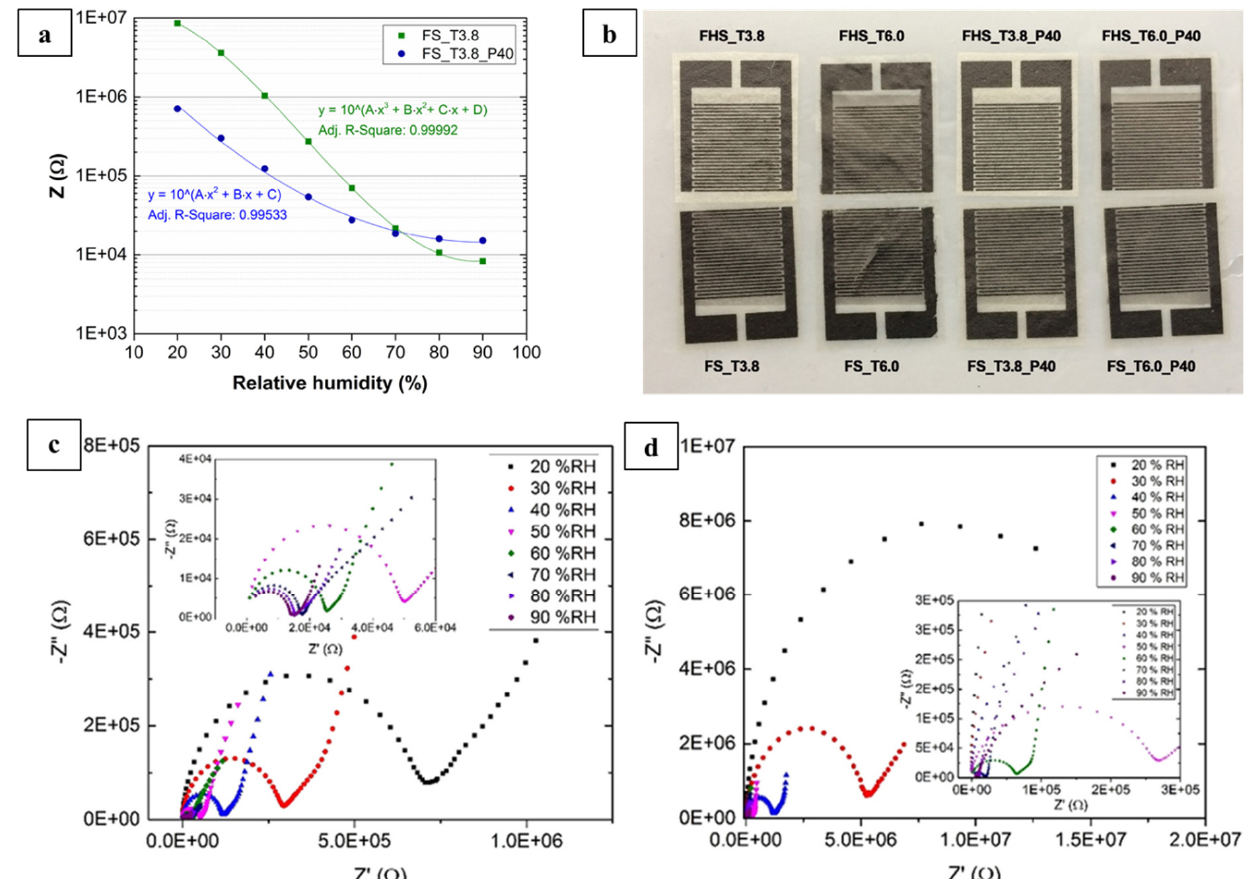
Figure 7. Calibration curves of tested samples (green, without plasticizer, and blue, with plasticizer) ( a ); RH sensors based on CNF films with screen-printed carbon electrodes ( b ). Impedance spectra under different humidity levels for the sample with plasticizer ( c ) and without plasticizer ( d ) at 25 °C. Insets: spectra for humidity levels 50, 60, 70, 80, and 90%, used with permission from ref. [53].